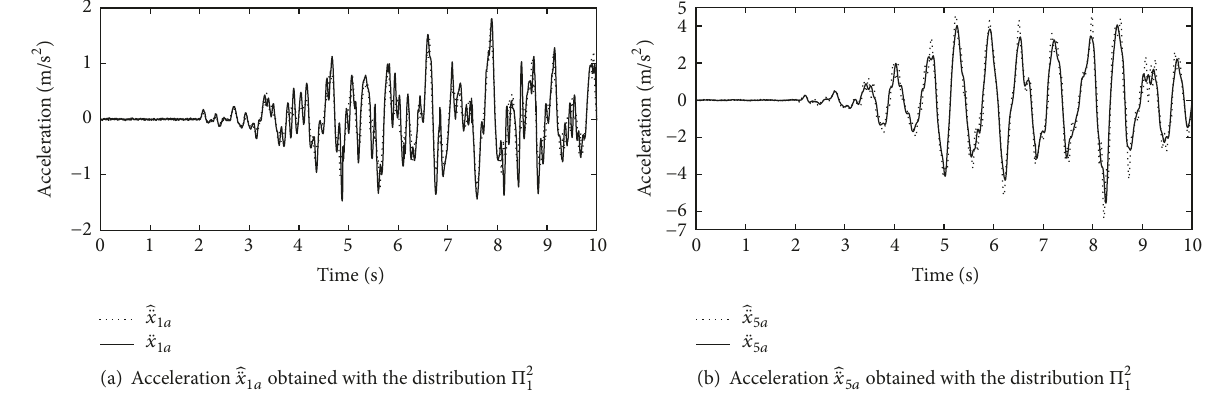
̂̈𝑥 1𝑎 and acceleration